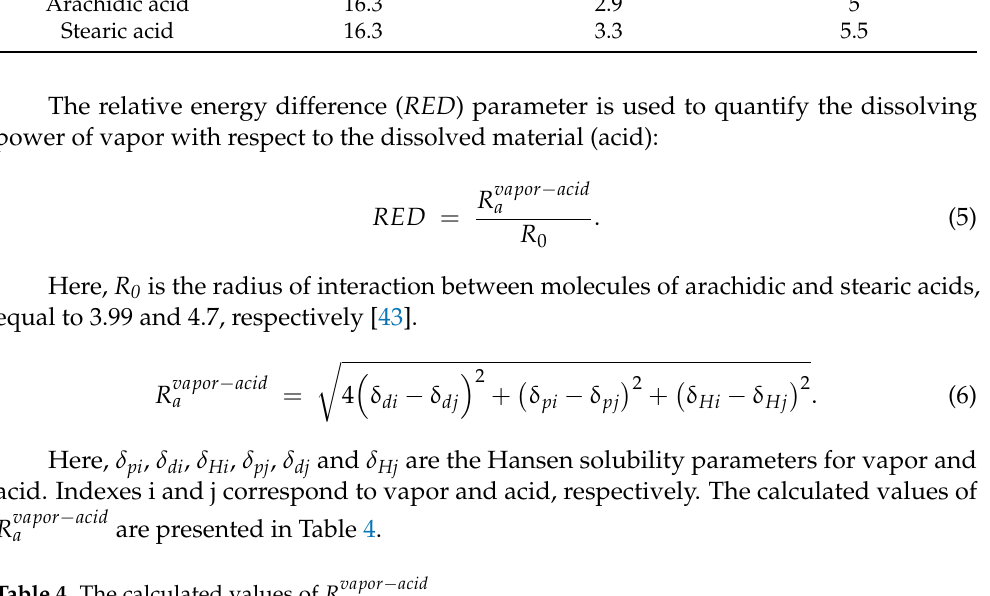
Table 4. The calculated values of R vapor